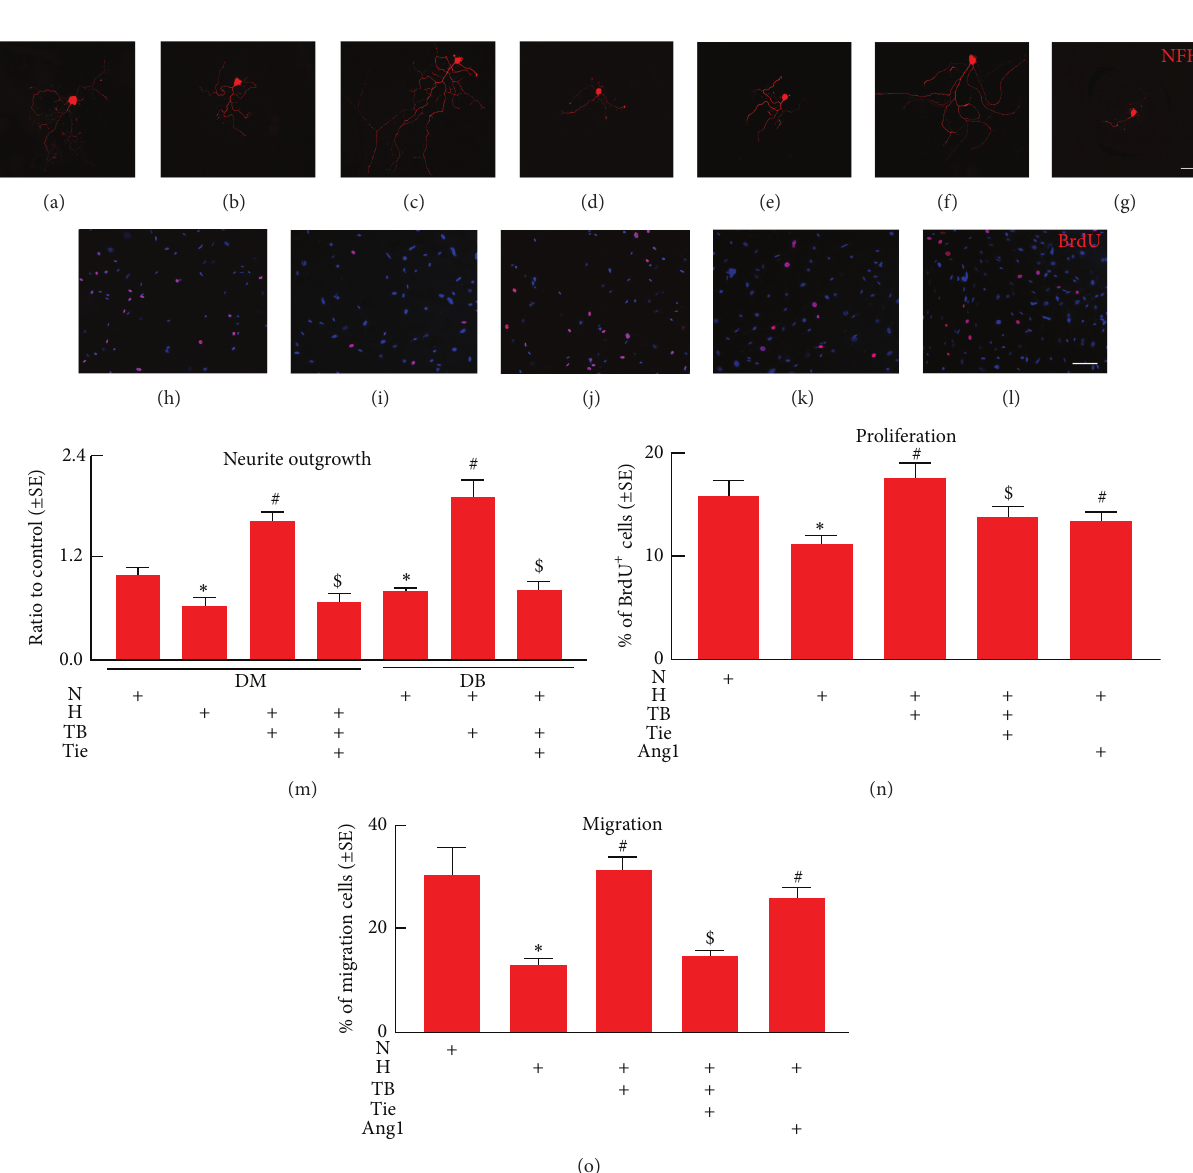
Figure 5: Effect of T 𝛽 4 on DRG neurite outgrowth and Schwann cell proliferation and migration. Panels (a) to (d) show NF-H immunoreactive nondiabetic DRG neurons cultured in conditioned medium harvested from Schwann cells cultured with normal glucose (N, (a)), high glucose (H, (b)), high glucose with T 𝛽 4 (+TB, 100ng/mL, (c)), and T 𝛽 4 with antibody against Tie2 (+Tie, 5 𝜇 g/mL, (d)). Panels (e) to (g) show NF-H immunoreactive diabetic DRG neurons cultured in conditioned medium harvested from Schwann cells cultured with normal glucose (N, (e)), normal glucose with T 𝛽 4 (TB, (f)), and T 𝛽 4 with antibody against Tie2 (+Tie, (g)). Panels (h) to (l) show BrdU immunoreactive Schwann cells cultured in normal glucose (h), high glucose (i), high glucose with T 𝛽 4 (j), T 𝛽 4 with anti-Tie2 (k), and high glucose with Ang1 (l). Panel (m) shows quantitative data of neurite outgrowth from DRG neurons. Panel (n) shows quantitative data of the percentage of BrdU immunoreactive Schwann cells. Panel (o) shows quantitative data of migration cells assayed by a modified Boyden chamber. Bar in 𝐺 = 50 𝜇 m. 𝐿 = 100 𝜇 m. ∗ 𝑃 < 0.05 and # 𝑃 < 0.05 versus the normal glucose (N) and high glucose (H) and $ 𝑃 < 0.05 versus high glucose or normal glucose with T 𝛽 4 group, respectively. 𝑛 = 6